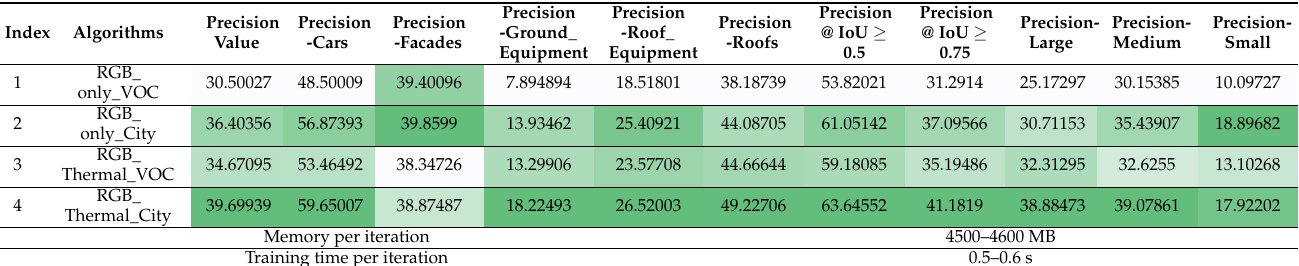
Table 5. Performance evaluation of Mask